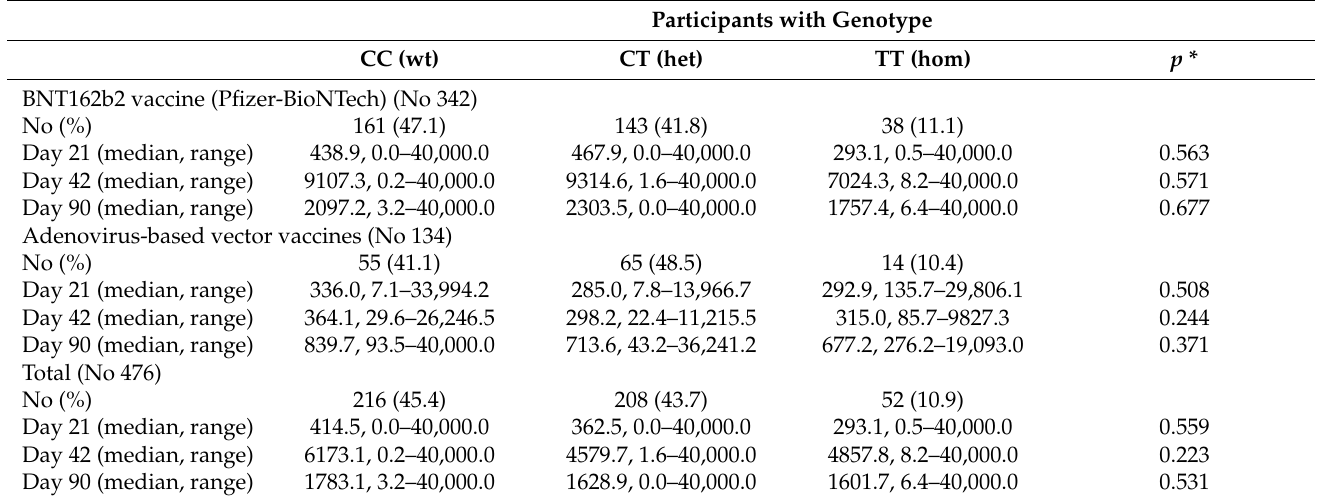
Table 2. Association of rs1883832 polymorphism with IgG responses (AU/mL) after COVID-19 vaccination.